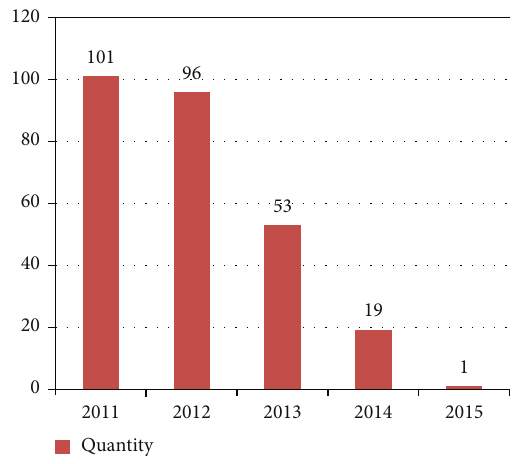
Figure 3: The license quantity authorized from May 2011 to December 2015. Data resource: https://www.sohu.com/a/